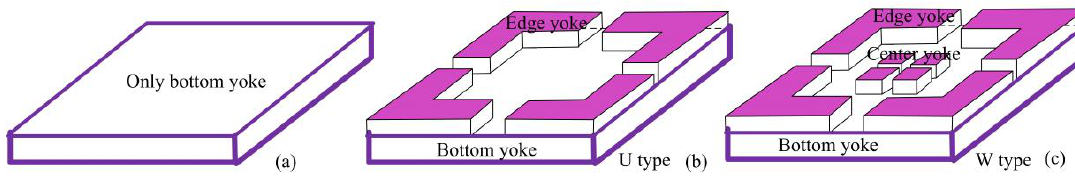
Figure 8. Three types of magnetic yoke designs. ( a ) Only bottom yoke; ( b ) U type yoke; ( c ) W type yoke.